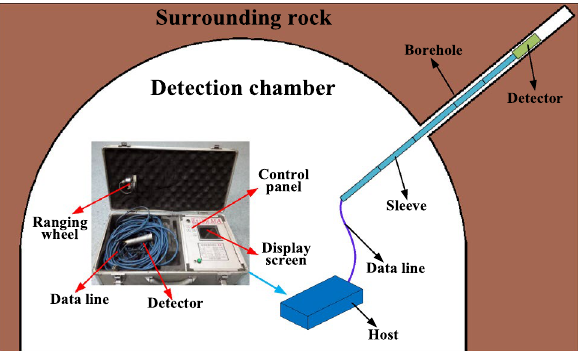
Figure 11. Detection scheme and equipment (This figure is drawn by the Microsoft office 2016, https:// www. micro soft. com/ zh- cn/ micro soft- 365/ previ ous- versi ons/ micro soft- office- 2016).